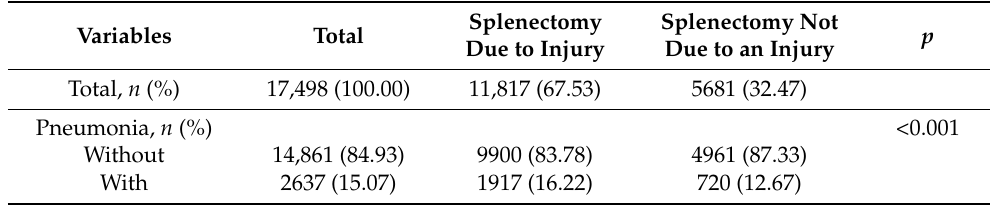
Table 2. Patients with splenectomy due to injury and due to other causes divided into having developed pneumonia or not.